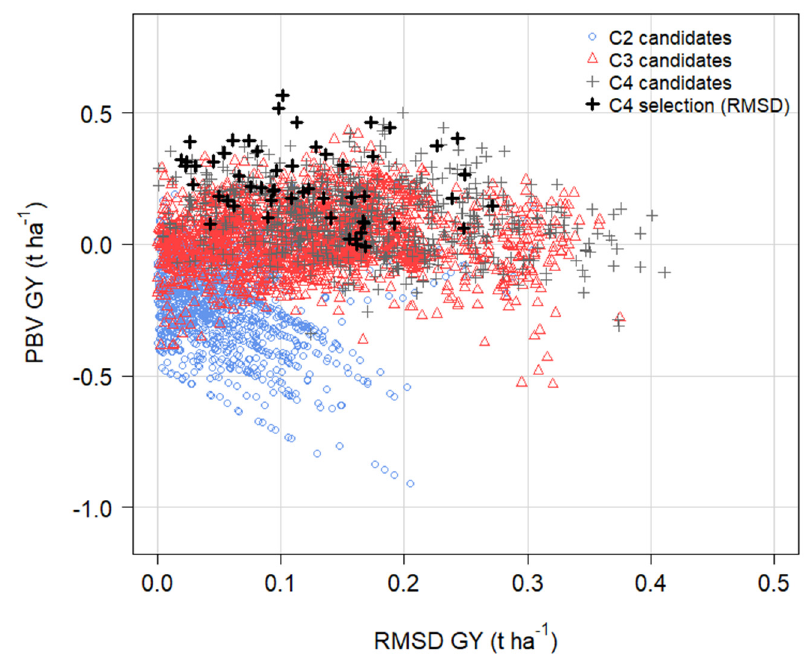
Figure 10. Change in predicted breeding values for grain yield (PBV GY, t ha -1 ) and root-mean- square deviation for grain yield (RMSD GY, t ha -1 ) of candidates for selection in cycle 2 (C2), cycle 3 (C3) and cycle 4 (C4) from the optimum MMM-FA model of the genotype × environment effects when RMSD GY was included in the economic index. The cycle 4 candidates selected as parents for crossing in OCS to begin cycle 5 are marked in bold black ‘+’ symbols.